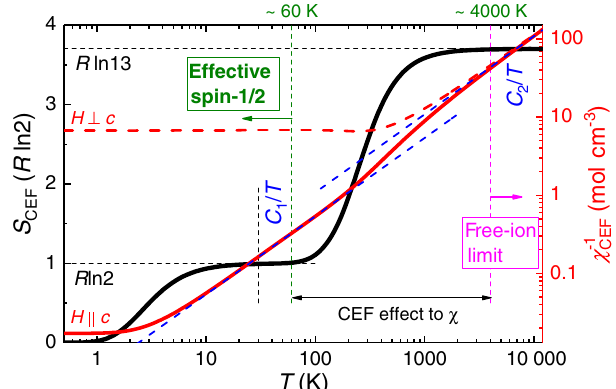
obtained from the combined fit. n